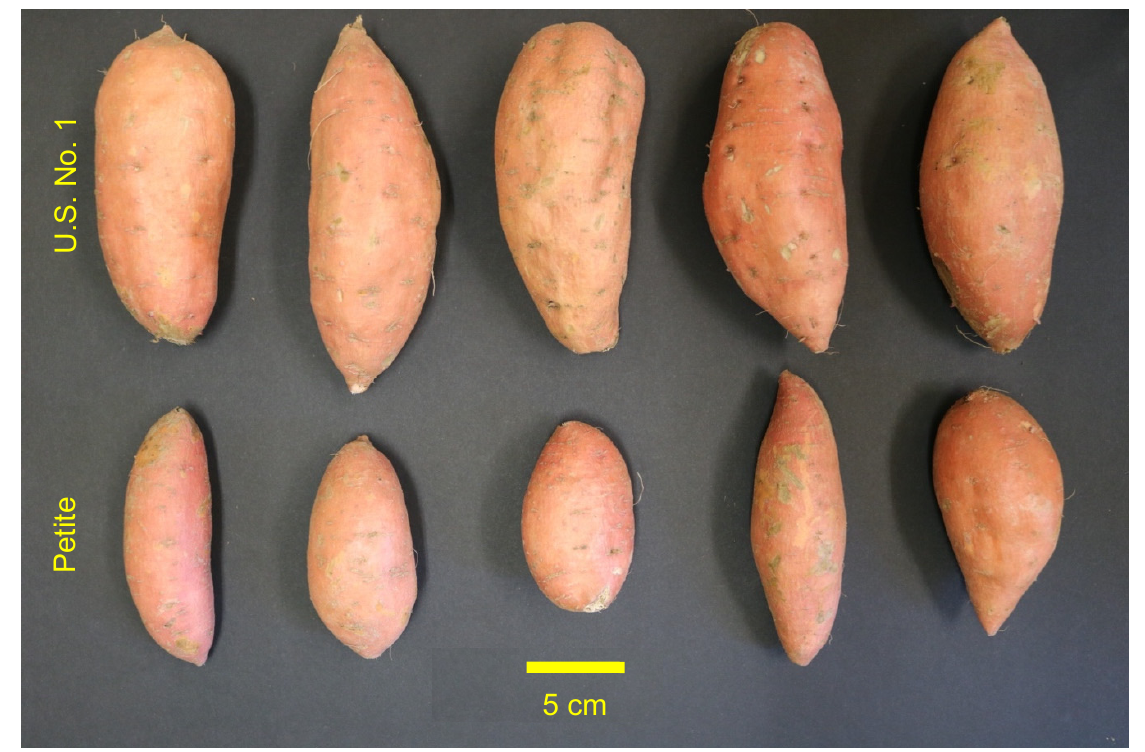
Figure 1. Size comparison of a U.S. No. 1 and Petite sweetpotato (cultivar ‘Averre’) storage root following the “United States for Grades of Sweetpotato” [4].